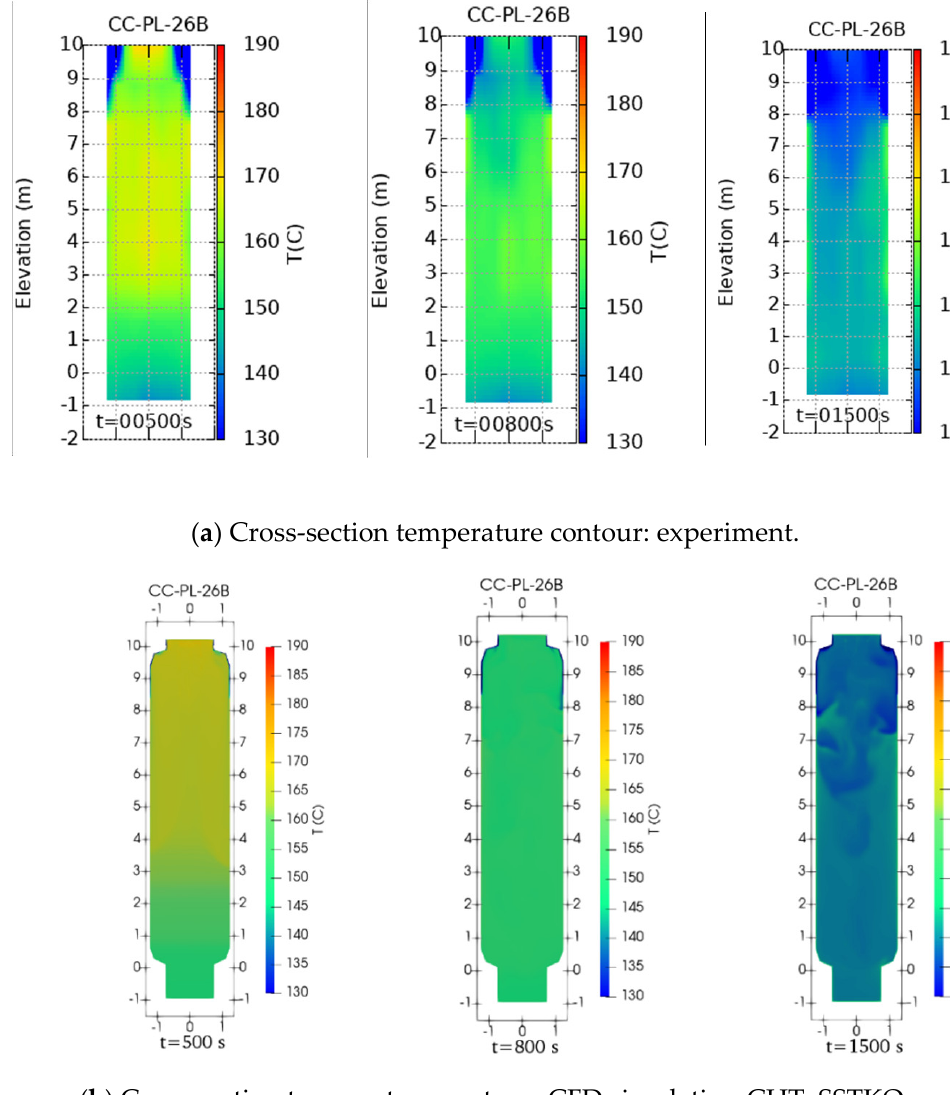
Figure 15. Comparison of the temperature contour on the cross-section as ( a ) measured and ( b ) numerically predicted by means of the SST k-ω turbulence model with CHT after water injection in the upper pool and middle jacket.